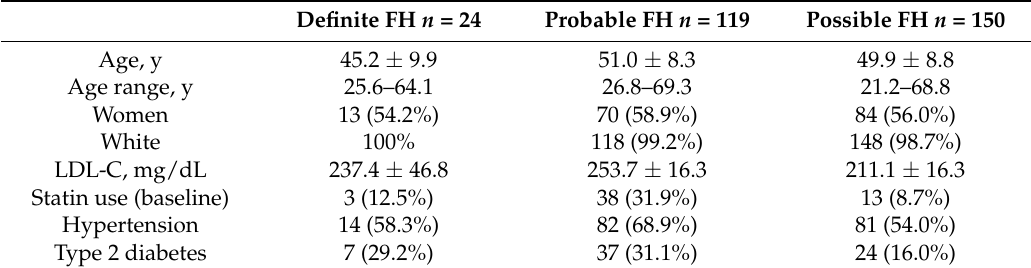
Table 1. Characteristics of patients with FH ( n =